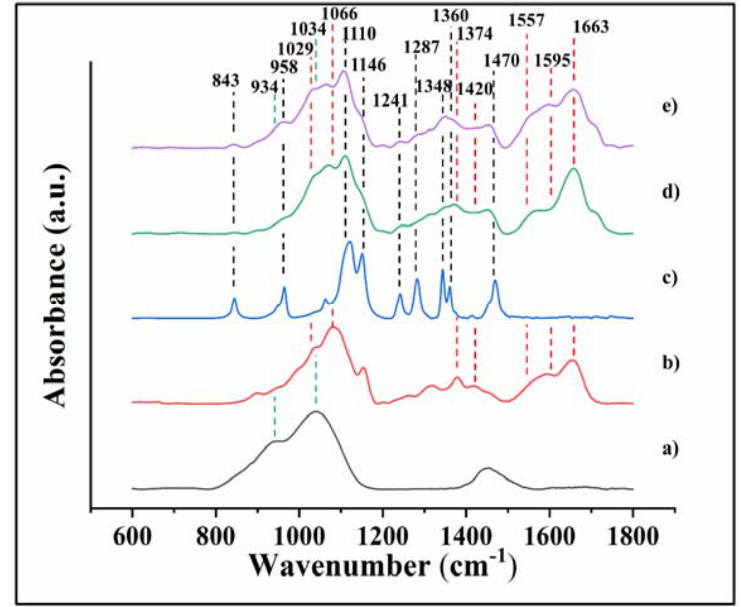
Figure 3. FTIR spectra of BG (a), CS (b), PEO (c), CS/PEO (d) and CS/PEO/BG (e) nanofibers. The labels, differently colored, indicate the most represented bands of BG (green), CS (red) and PEO (black).